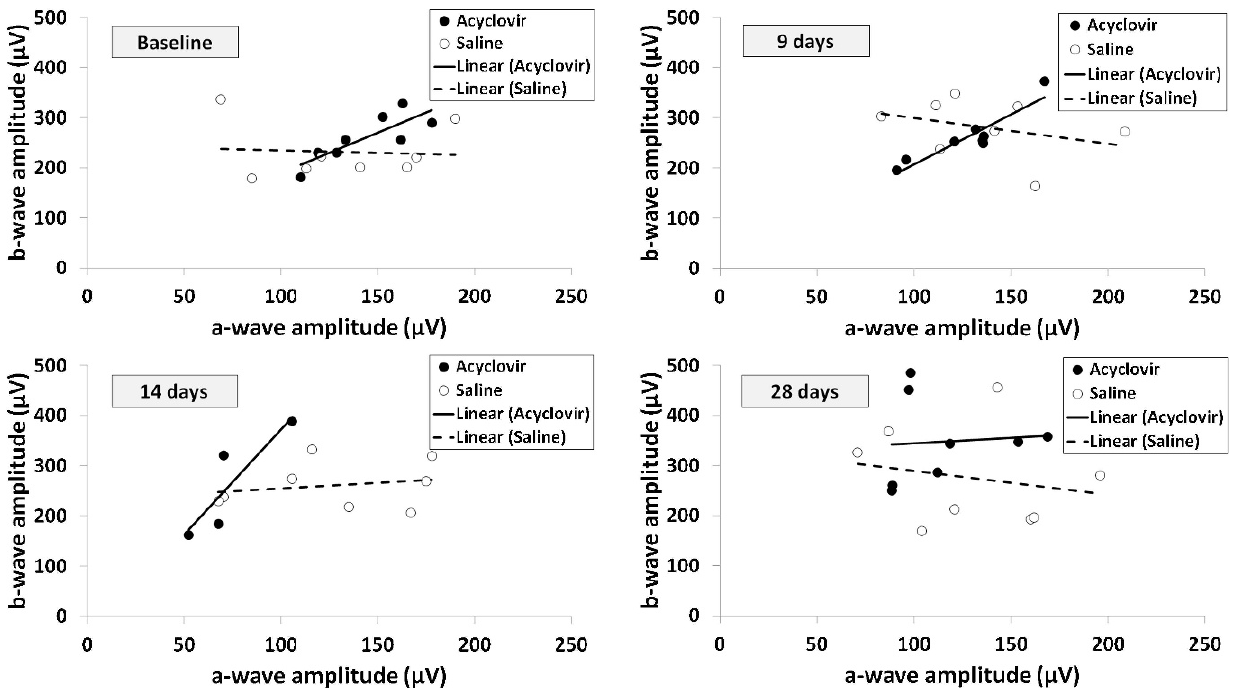
Figure 4 - b-wave to a-wave (dark-adapted state, 30 cd.s/m 2 ) correlations between the eyes that were injected with acyclovir and saline at different time points. Each point represents the a- and b-wave amplitudes from one